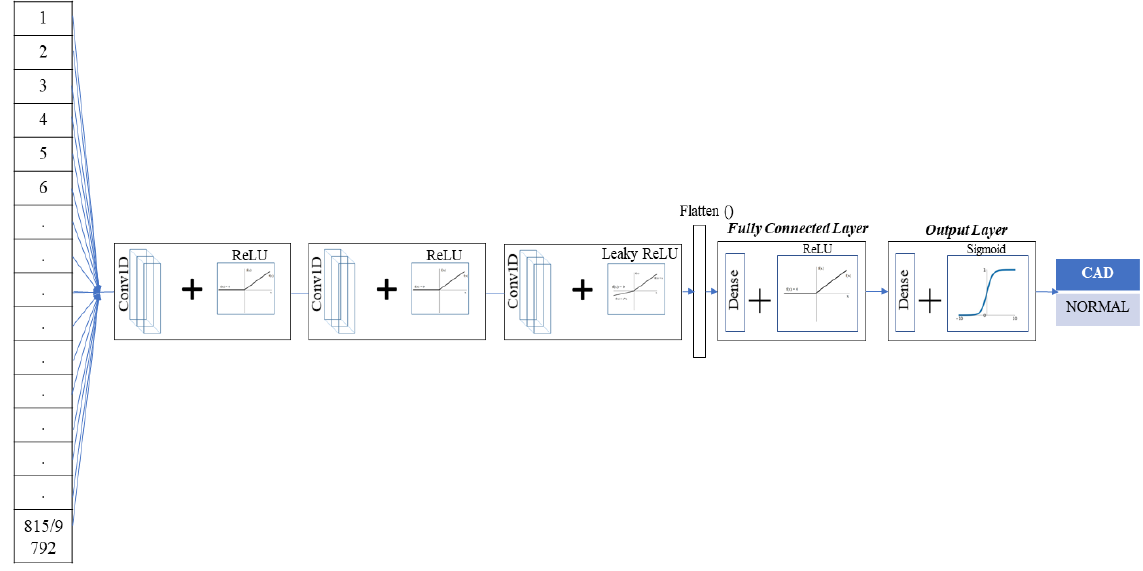
Figure 15. The best CNN model for the single-lead ECG and the multi (12)-lead ECG. The results of Tables 4 and 5 indicate that a three-layered network with ReLU,